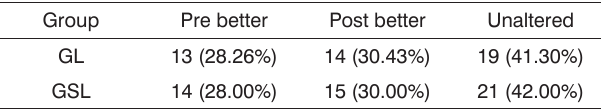
Table 2. Response frequency in the perceptual auditory analy- sis - best utterance of vowels, before and after exercises Group